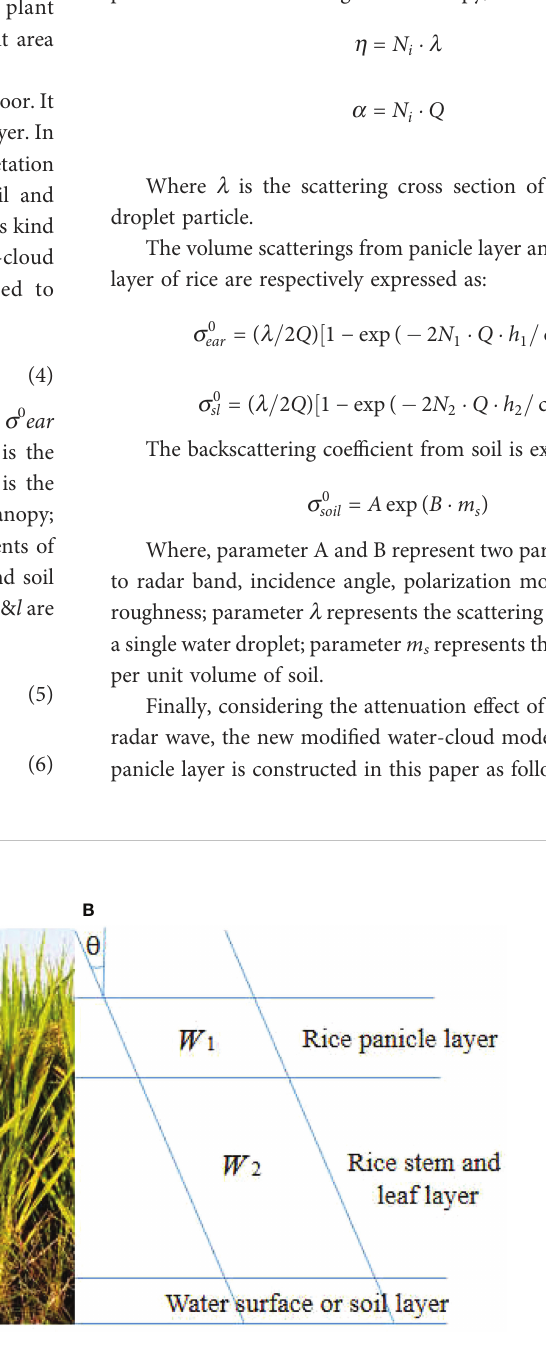
FIGURE 4 The simulation fi gure of the newly constructed water-cloud model based on panicle layer. (A) is the actual scene of the rice plant. (B) is the schematic diagram of new model. The canopy of rice is mainly divided into two parts: the pancicle layer, stem and leaf